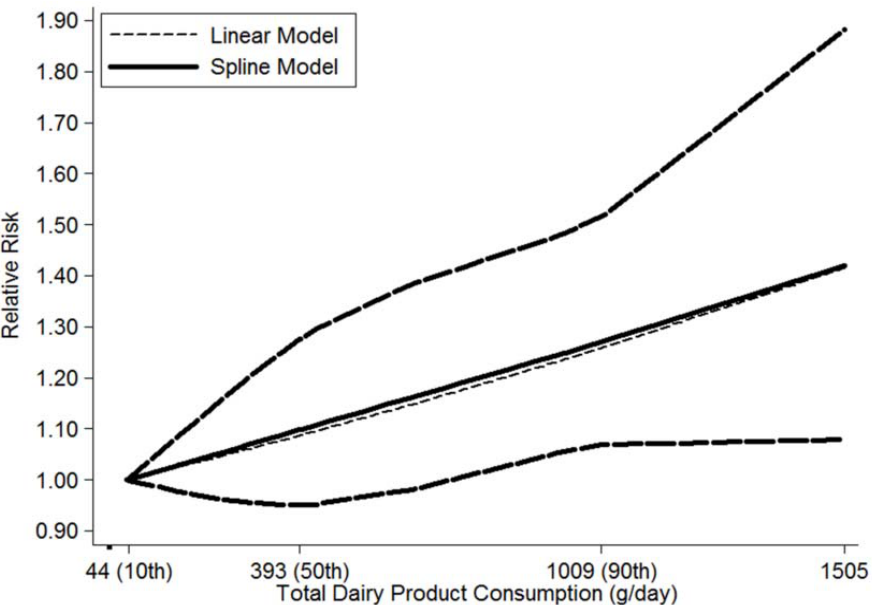
Figure 3. The dose-response analysis between total dairy product consumption and the risk of NHL with restricted cubic splines in a multivariate random-effects dose-response model. The solid line and the long dash line represent the estimated relative risks and their 95% CIs. Short dash line represents the linear relationship. The 10th, 50th and 90th percentiles represent three knots of total dairy product consumption.